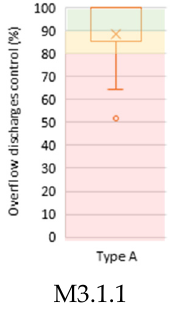
M3.1.5 Figure 7. Results of the validation applied to the wastewater utilities: objective 3.